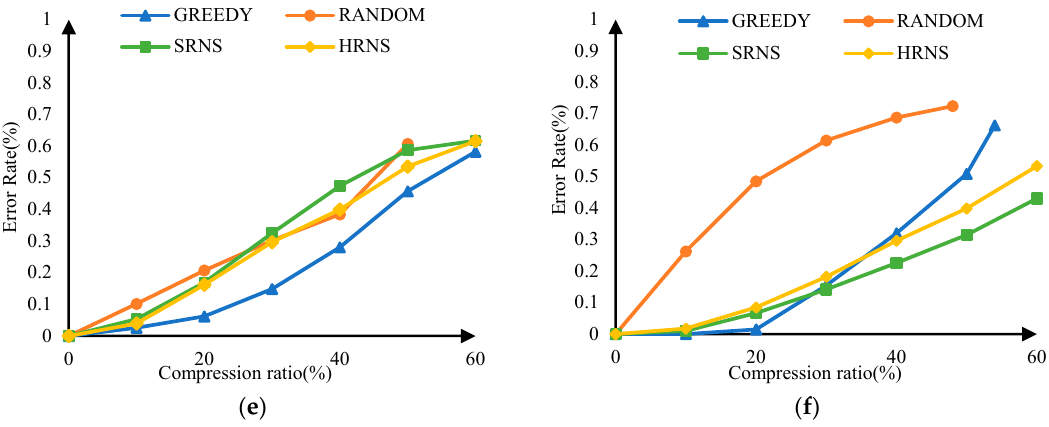
Figure 8. Graph summary error. ( a ) 2002-2 dataset. ( b ) 2500-2 dataset. ( c ) Blog dataset. ( d ) Cora dataset. ( e ) Ca-GrQc dataset. ( f ) Ucforum dataset.